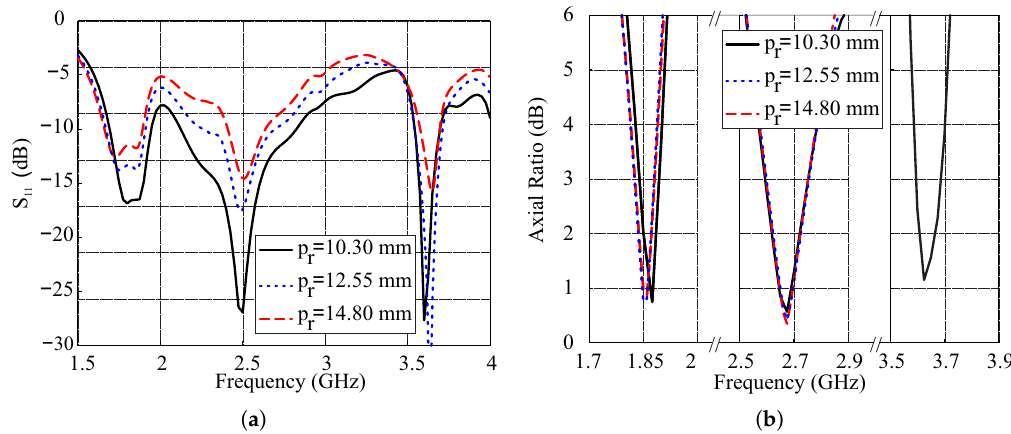
Figure 6. Simulated effects of variations in position p r of the square microstrip ring (SMR): ( a ) Reflection coefficients; ( b ) Axial ratios.